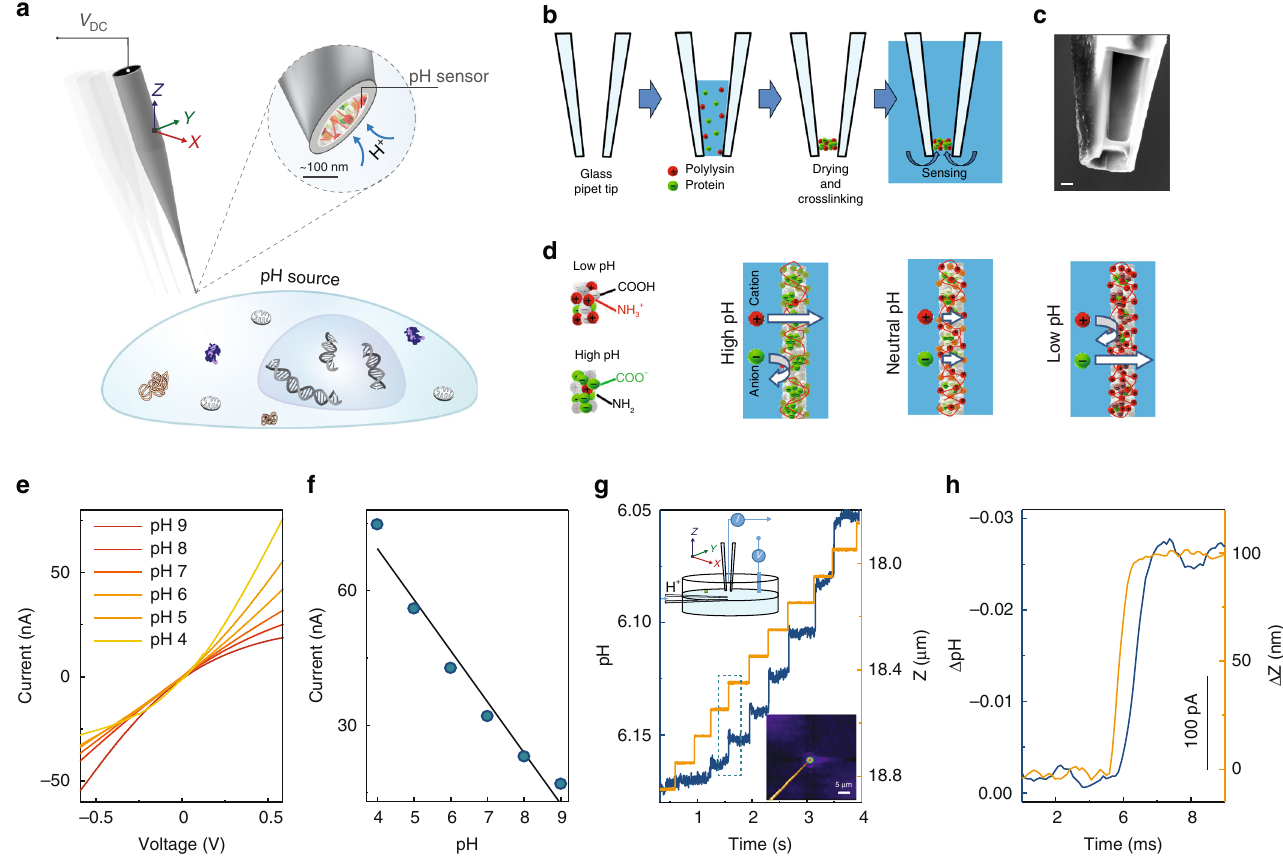
Fig. 1 Nanoprobe pH sensor fabrication and characterisation. a Conceptual image demonstrating the dynamic mapping of extracellular pH in three dimensions with high spatial resolution. b The nanoprobe pH sensors were made by immobilising a mixture of glucose oxidase and poly-l-lysine and made via drying-mediated self-assembly at the tip of a pulled glass nanopipette by crosslinking with glutaraldehyde. c A scanning electron microscopy image (scale bar 500 nm) showing the tip of the pH probe consisting of a thin membrane. The pipette tip has been focused ion beam milled using a slice and view technique. d Proposed working principle of the sensor, by which the nanomembrane shows preferential permeability for anions at low-pH and cations at high-pH. e Current-voltage characterisation of the sensor at varying pH, and f current vs pH at 0.6 V showing good linear response in the pH range of 4 – 9 (R 2 = 0.96, p < 0.001, Pearson ’ s correlation). g A nanopipette was used as a highly localised H + source for testing the pH mapping capability of the nanoprobe sensor (left top inset). 2D top view showing the pH distribution pro fi le (right bottom inset) as obtained using SICM mapping. Real-time pH measurements that allow assessing the probe response time and sensitivity. The probe is moved to the H + source in the z-direction using a fast piezo- stage. h A magni fi ed plot of the dotted-box shown in g , demonstrating the sensitivity and resolution of the nanoprobe pH